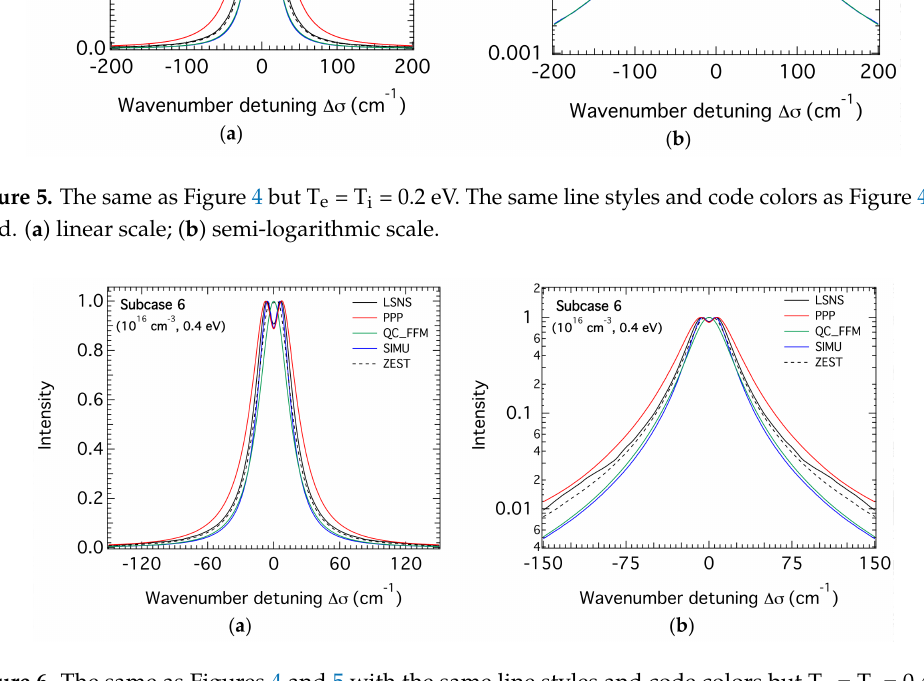
Figure 6. The same as Figures 4 and 5 with the same line styles and code colors but T e = T i = 0.4 eV. ( a ) linear scale; ( b ) semi-logarithmic